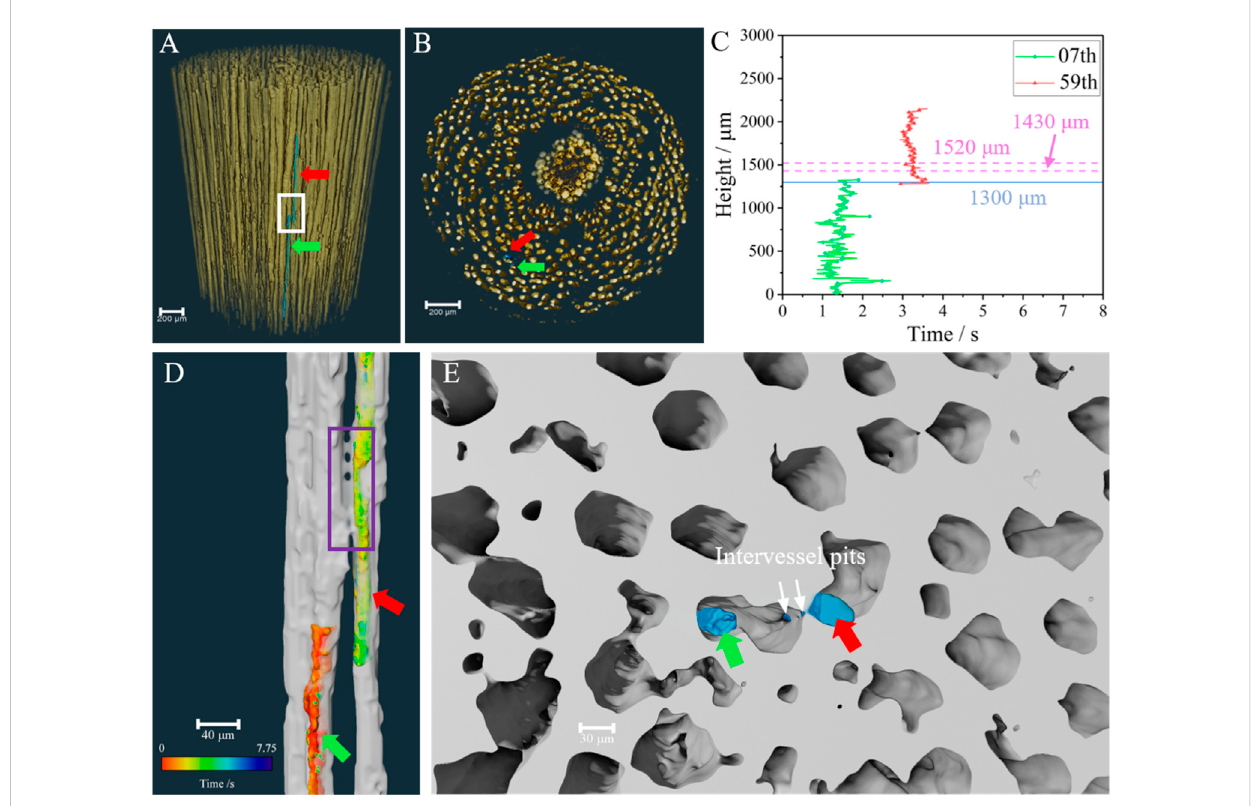
FIGURE 4 Relaytransport betweenadjacentvessels. (A) Fusionofvesselsandrelaytransportwatercolumnswiththestereoviewand (B) Verticalviewfromthe top. (C) Height-time curve for the re fi lling column in vessels No. 7 and No. 59, while the blue solid line and pink dash lines representing the height of the relaypoint andtheintervessel pits,respectively. (D) Thesideview ofadjacent vesselsand water column extracted fromthewhite rectangle in (A) , andthe relay region are marked by purple rectangle. (E) Cross section view of the selected part of the purple rectangle in (D) . The blue parts in (A,B,E) , and colored parts in (D) represent water. In addition, green and red arrows marked the re fi lling column in vessels No. 7 and No. 59,